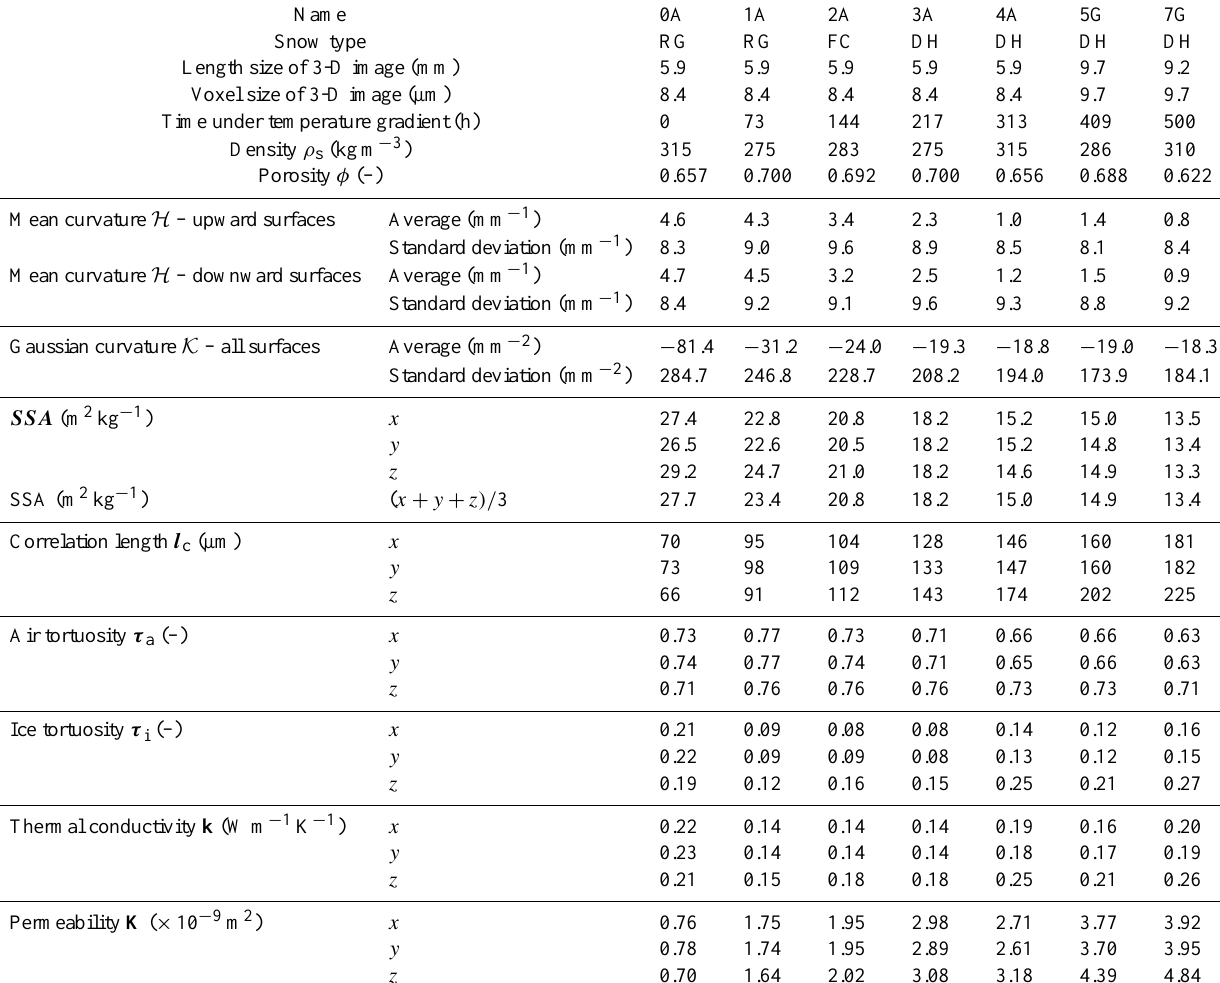
Table 1. Microstructural and physical properties computed from 3-D images. Snow types are given according to the international classifica- tion (Fierz et al.,